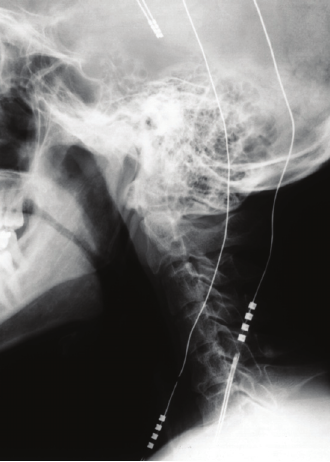
Figure 3: Lead fracture with connection located in cervical region.